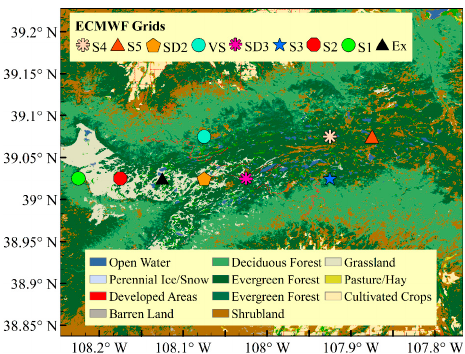
Figure 2. Land-use and land-cover (LULC) map centered over Grand Mesa. The nine snowpit clusters (Table S1) corresponding to nine ECMWF grid cells marked in Figure 1 are also marked here using the naming convention indicated in the legend.